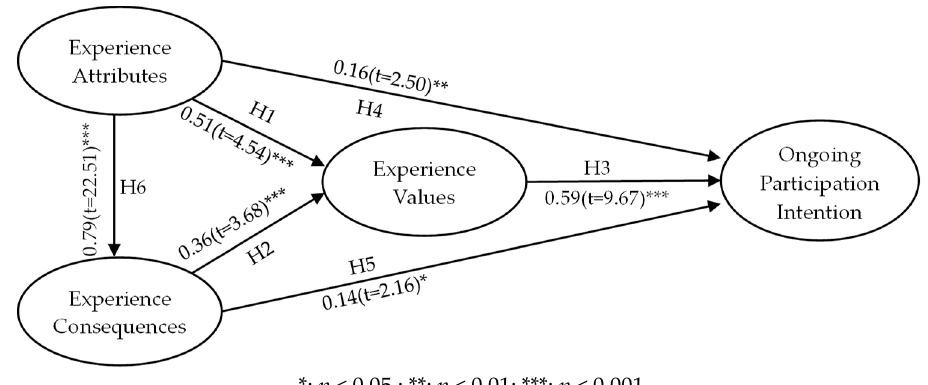
Figure 2. Path results for the behavior intentions of older adult